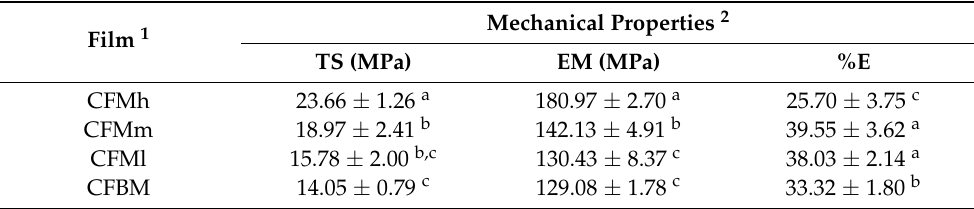
Table 2. Mechanical properties of Brachystola magna chitosan films compared to commercial chitosan films